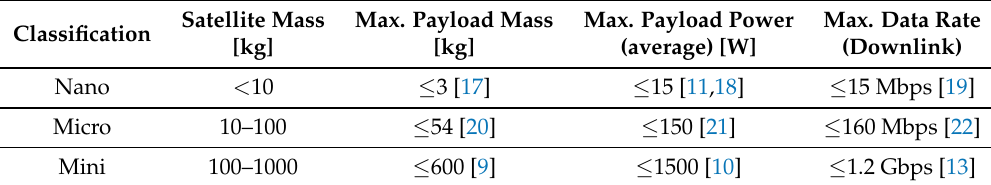
Table 2. Summary of survey of commercial small platforms